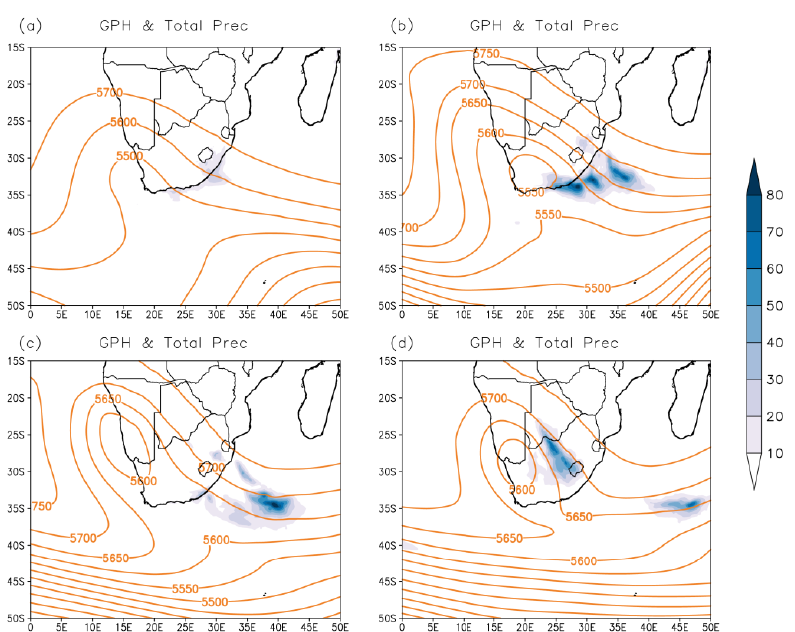
Figure 5. Geopotential height (m) 500 hPa and total rainfall (mm) during ( a ) 14, ( b ) 15, ( c ) 16, ( d ) 17 August 2002.